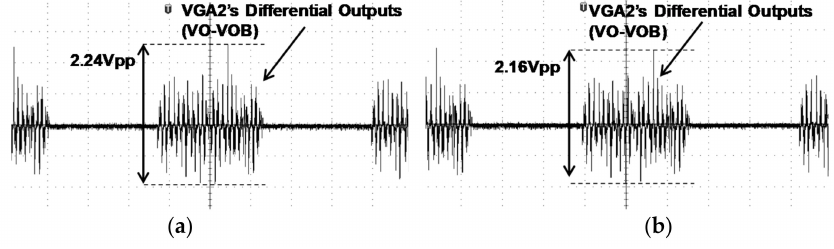
Figure 25. Measurement of ( a ) touch and ( b ) no touch OFDM signal.